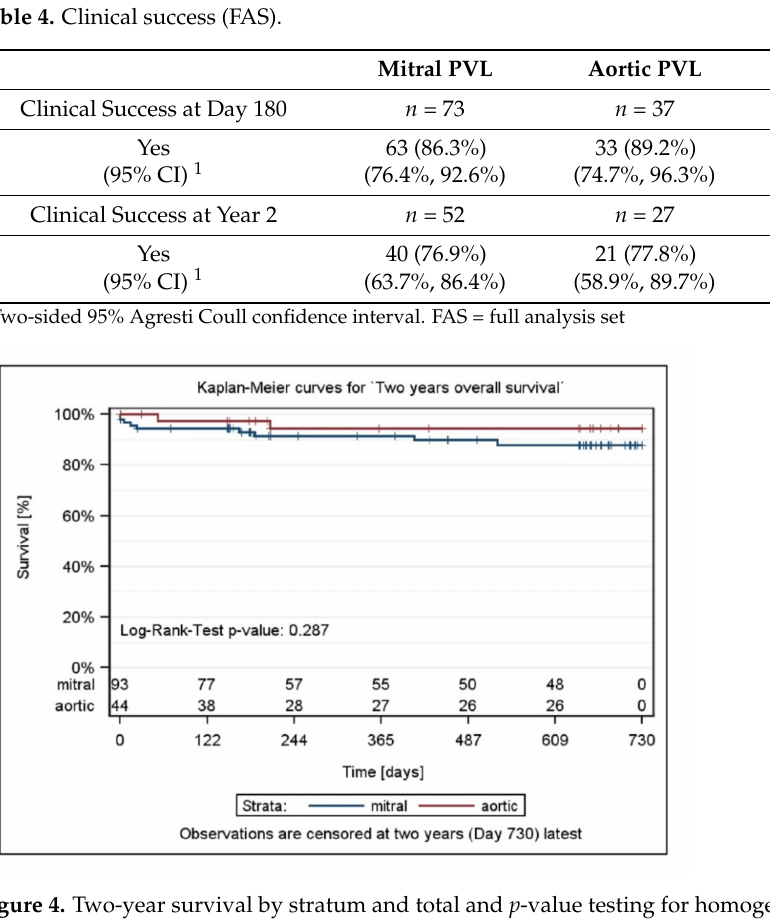
Figure 4. Two-year survival by stratum and total and p -value testing for homogeneity. Clinical success was achieved in similar proportions of patients with Mi and Ao PVL repairs: 63/73 patients (86.3%; 95% CI: 76.4%, 92.6%) with Mi PVLs and 33/37 patients (89.2%; 95% CI: 74.7%, 96.3%) with Ao PVLs. At Year 2, clinical success was achieved in 61/79 patients (77.2%; 95% CI: 66.8%, 85.2%). A total of 50 adverse events (AEs) were reported in 37 patients (27.0%) in the SAF population, and 35 serious adverse events (SAEs) were reported in 27 (19.7%) patients. A total of six6SAEs were considered possibly or probably related to the device/procedure and included device embolization in three patients, residual leak in two patients and a vascular complication (pseudoaneurysm at femoral artery puncture site) in one patient. Among the three patients (2.2%) with device embolization, attempts to recapture the embolized device with the snare failed: two patients underwent redo surgery immediately after the PLD migrated in the left ventricle and in the left atrium, respectively, while the third patient underwent redo surgery three weeks after the procedure due to late partial detachment of one of the three devices implanted. Of the two patients (1.5%) with residual leaks, one patient underwent a repeated successful closure procedure, and the second one had residual paravalvular leak through the device, which caused severe anemia requiring four units of blood transfusion on a weekly